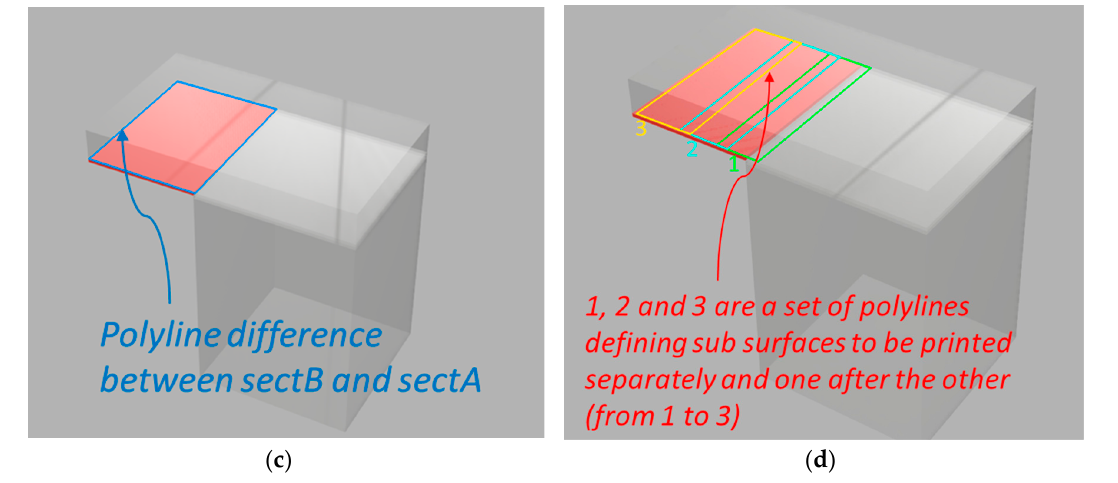
Figure 6. Proposed printing approach divided into four steps ( a – d ).